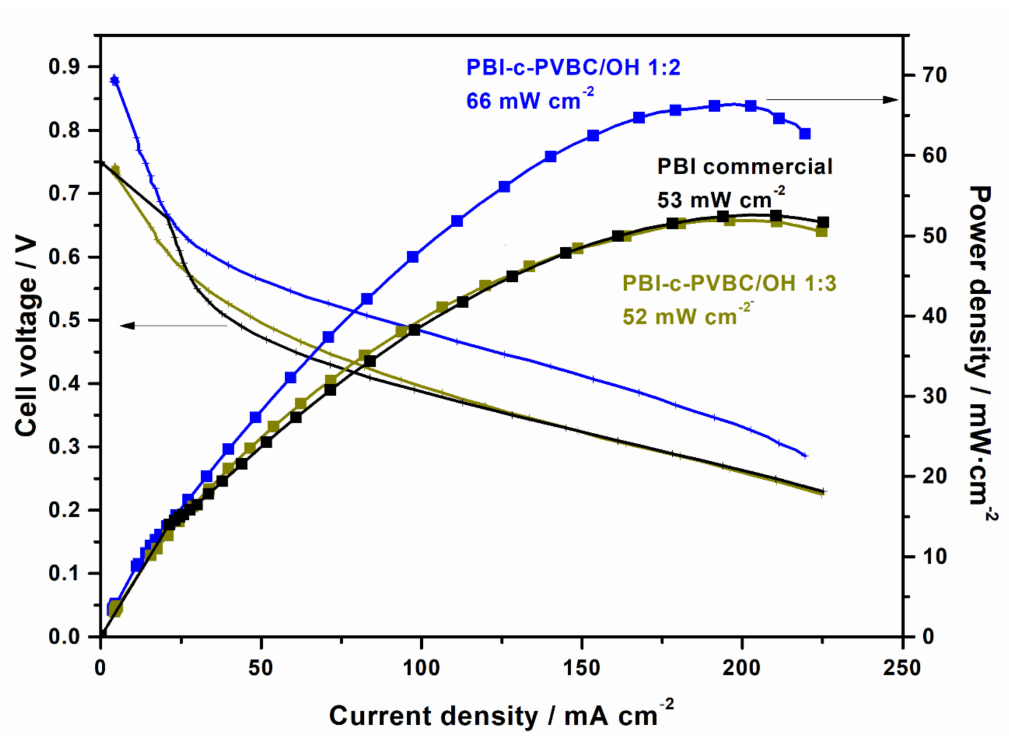
Figure 11. Direct ethanol fuel cells (DEFC) polarization (line) and power density (squares) curves using PBI-c-PVBC / OH membranes and compared to pristine PBI / KOH membrane. Commercial PBI result from